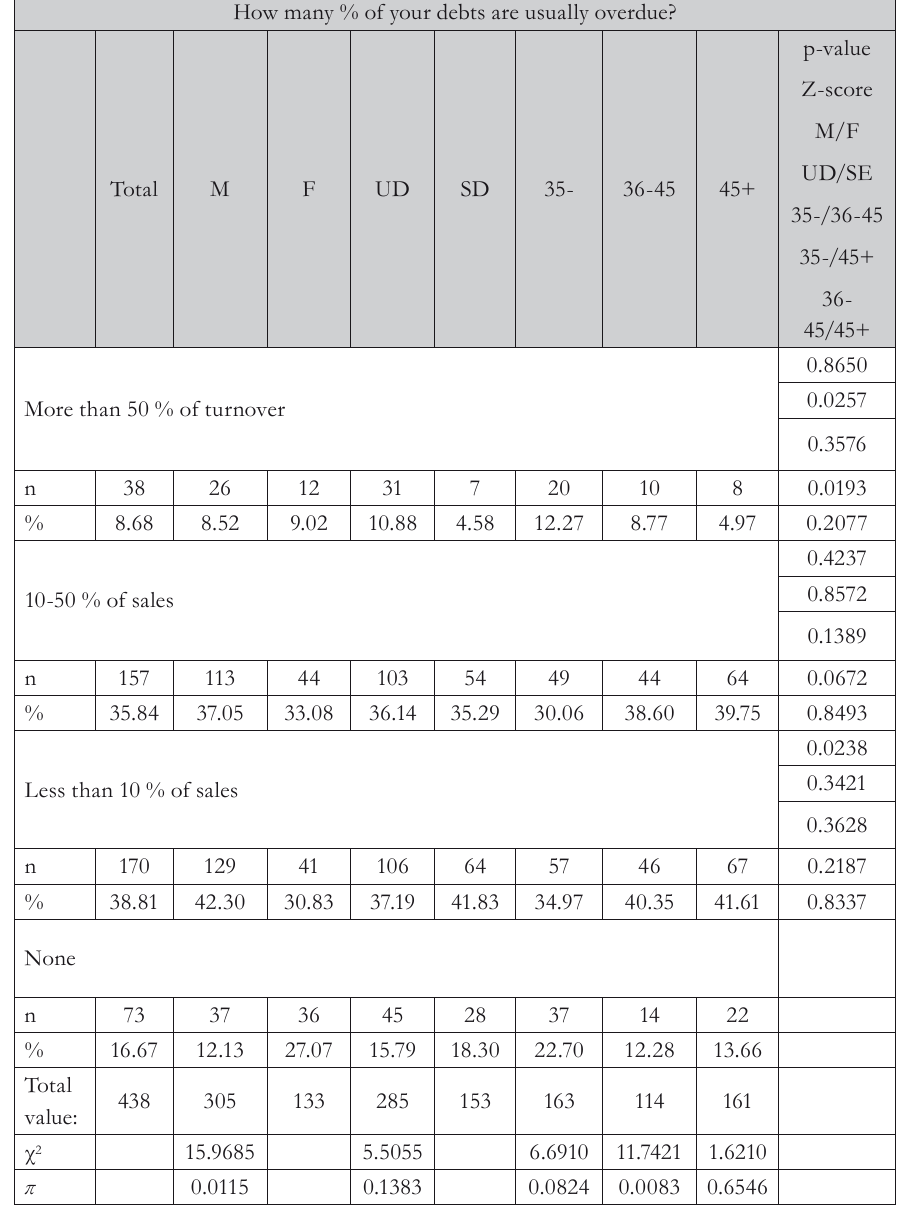
Tab. 2 – The structure of the overdue receivables. Source: own processing How many % of your debts are usually